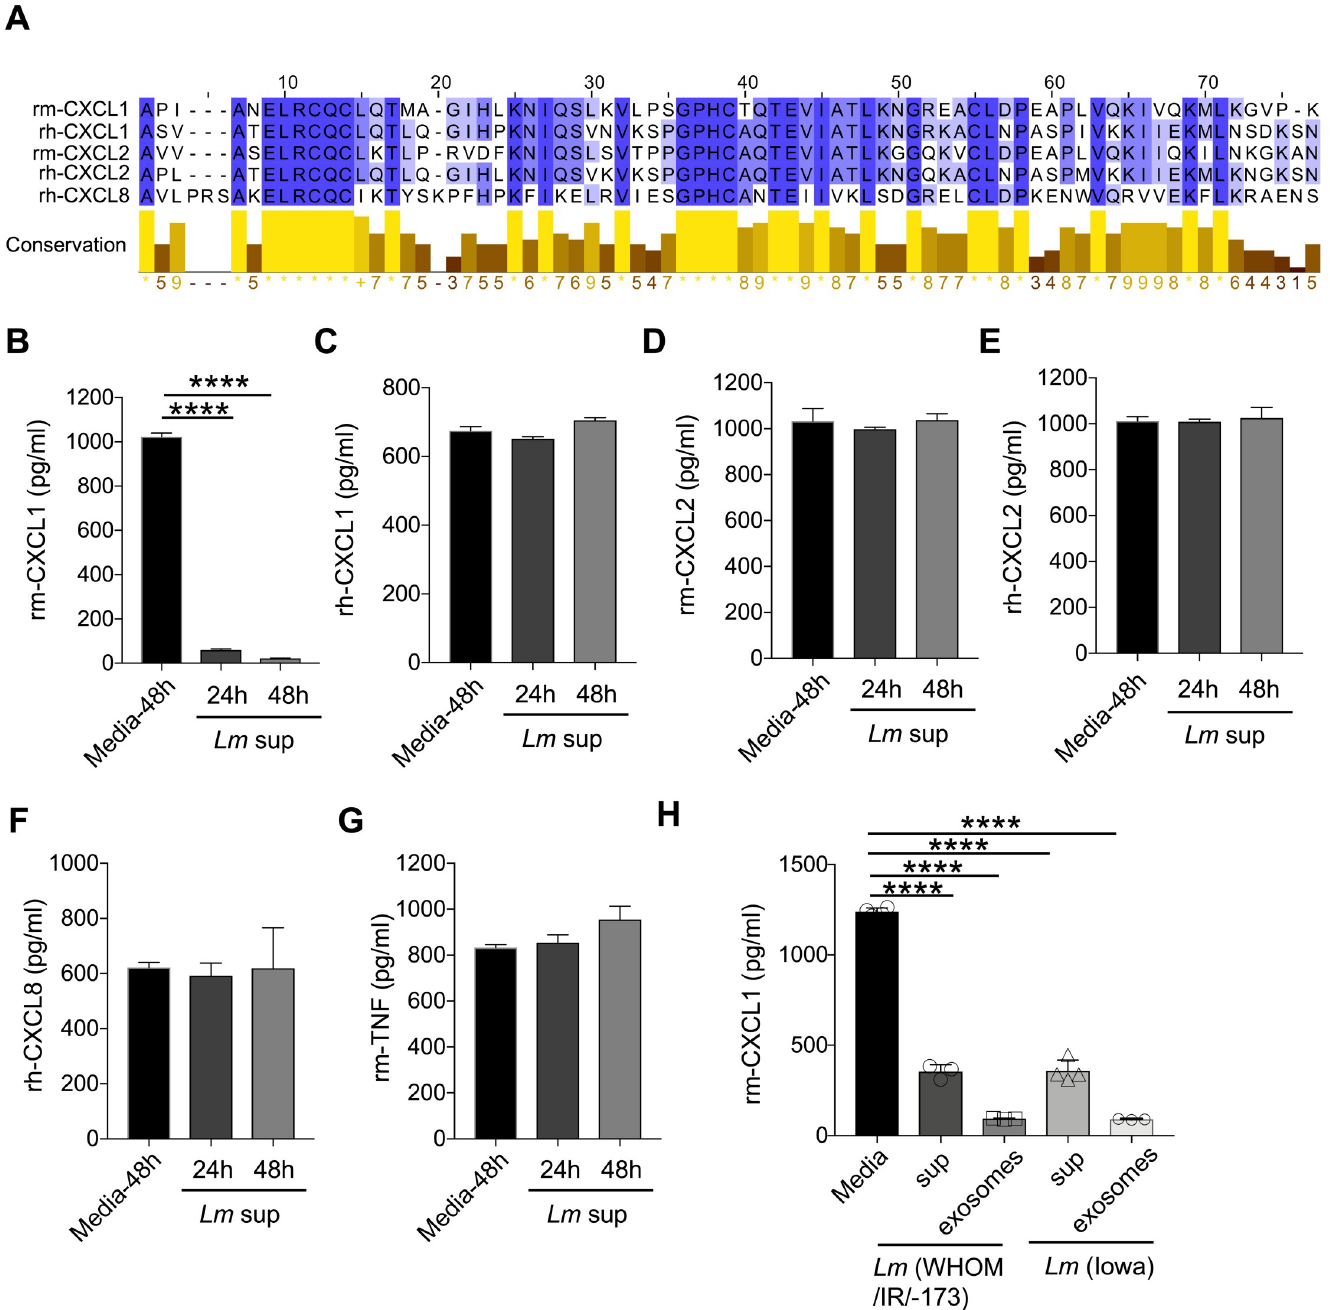
Fig 3. Selective inhibitory activity of L . major on recombinant murine CXCL1. (A) Sequence alignment of recombinant murine (rm) and recombinant human (rh) CXCL1, CXCL2, and CXCL8. (B) Rm-CXCL1, (C) rh-CXCL1, (D) rm-CXCL2, (E) rh-CXCL2, (F) rh-CXCL8, and (G) rm-TNF were incubated with or without Lm sup for indicated time-points and ELISA was performed to quantify the mentioned cytokine/chemokines. (H) Rm-CXCL1 was incubated with or without Lm sup or Lm exosomes derived from indicated strains of L . major for 24h, and CXCL1 quantification was performed as in (G). Data are representative of at least three independent experiments. Results are represented as mean ± SEM. ���� P <